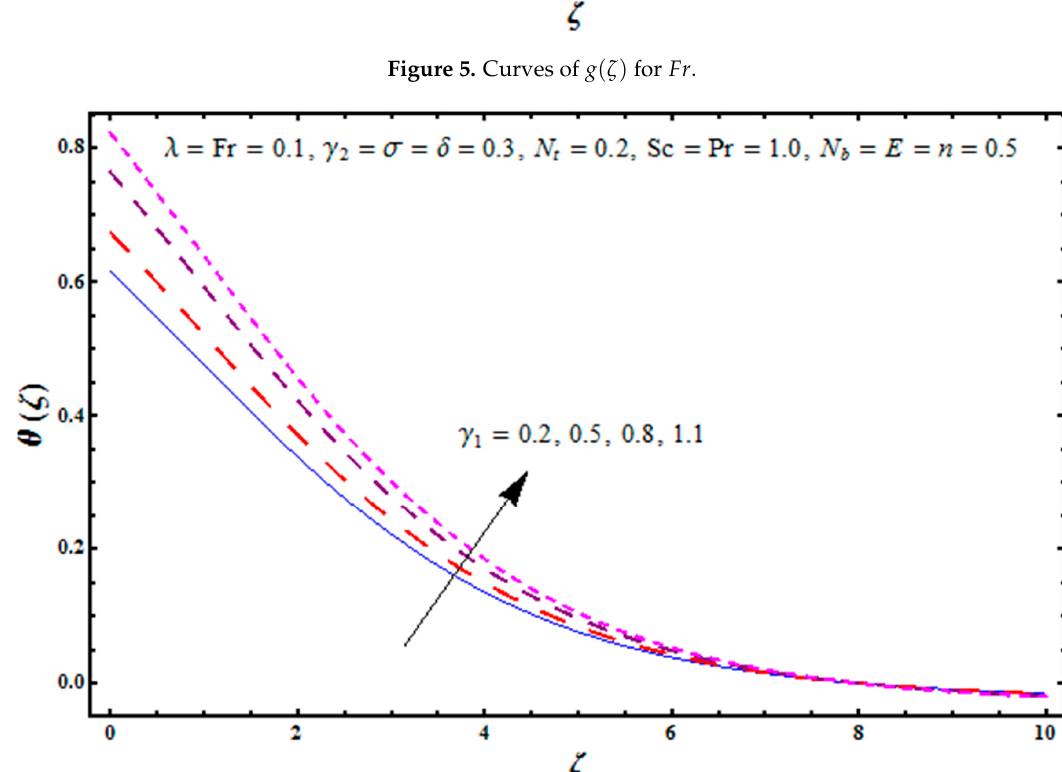
Figure 6. Curves of θ ( ζ ) for γ 1